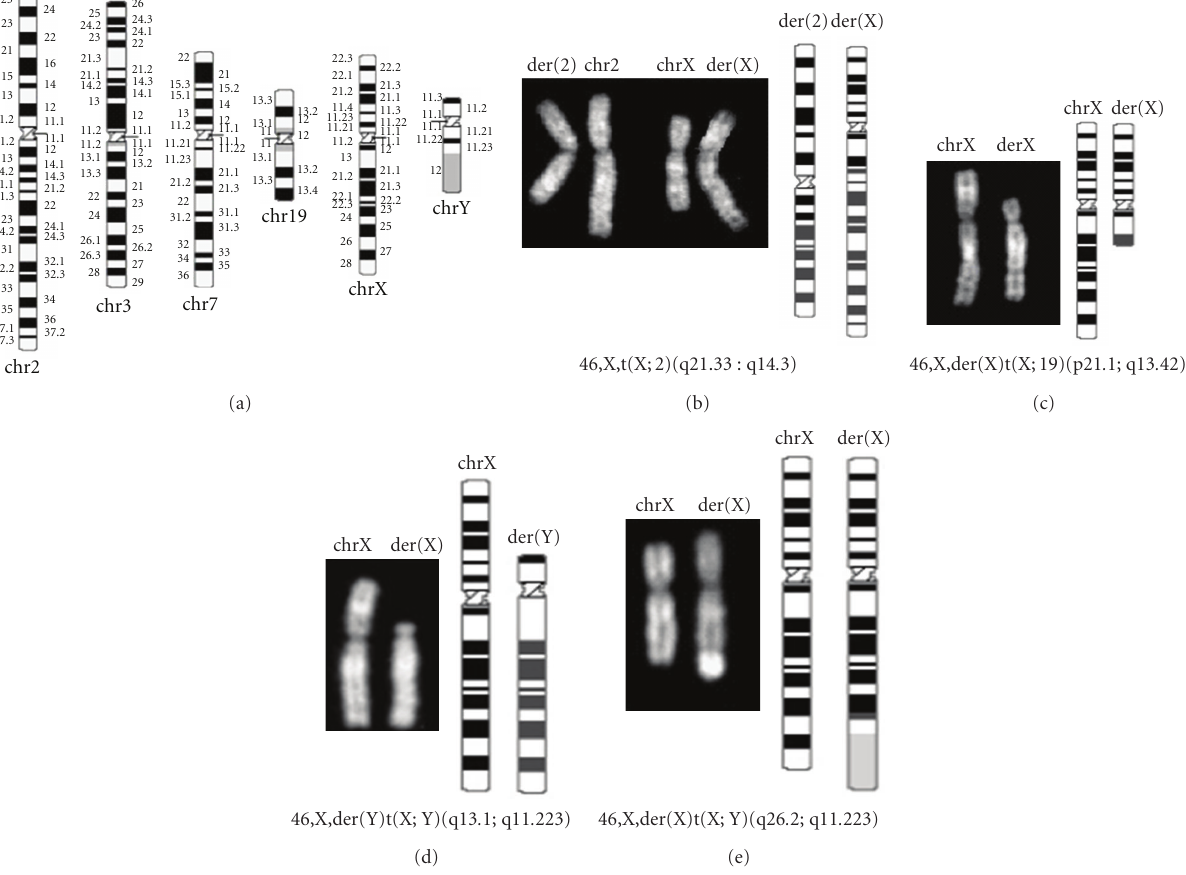
Figure 1: Conventional cytogenetic analysis. (a) Ideograms of the normal chromosomes (550-band level). (b)–(f) Chromosomal abnormalities found in 5 patients a ff ected by POF. Partial Q-banding karyotype on the left and ideograms of derivative chromosome on the right.